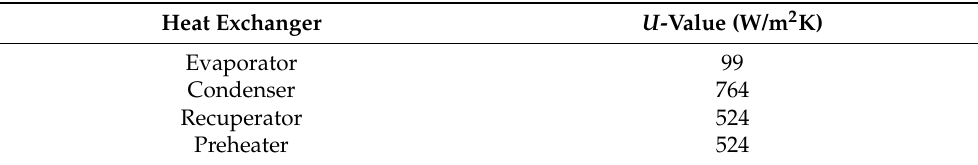
Table 9. Assumed values of overall heat transfer